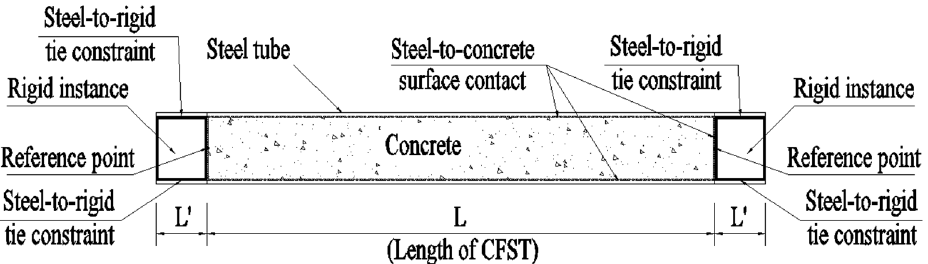
Figure 3. Illustration of modelling.